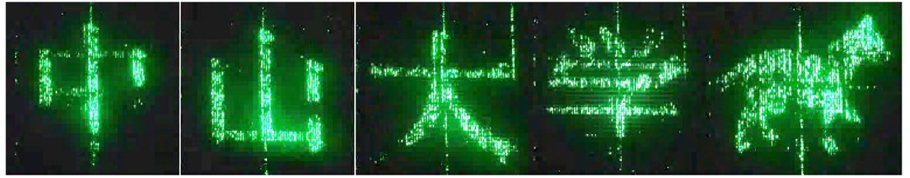
Figure 6. Images showing the device displaying Chinese characters and a cartoon image of a walking dog.